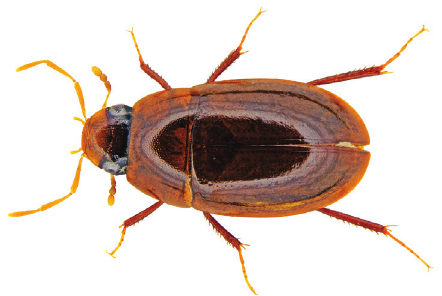
Figure 28. Chasmogenus cf. patrizii (Balfour- Browne, 1948)